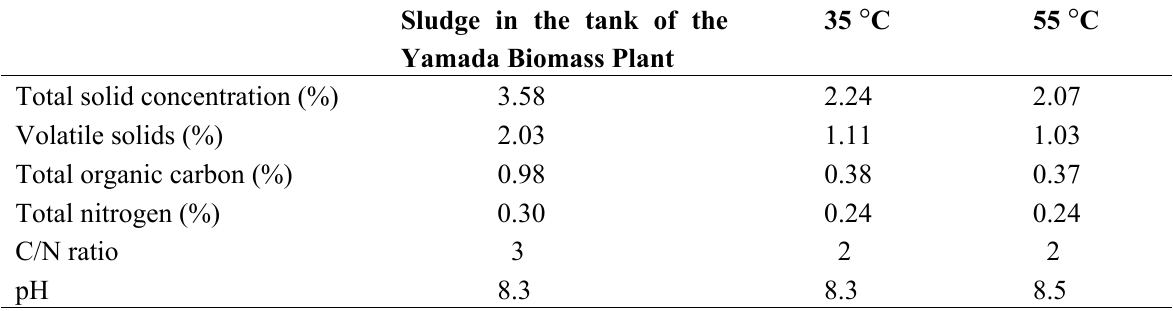
Table 2. Characterization of the sludge for anaerobic biodegradation test and original